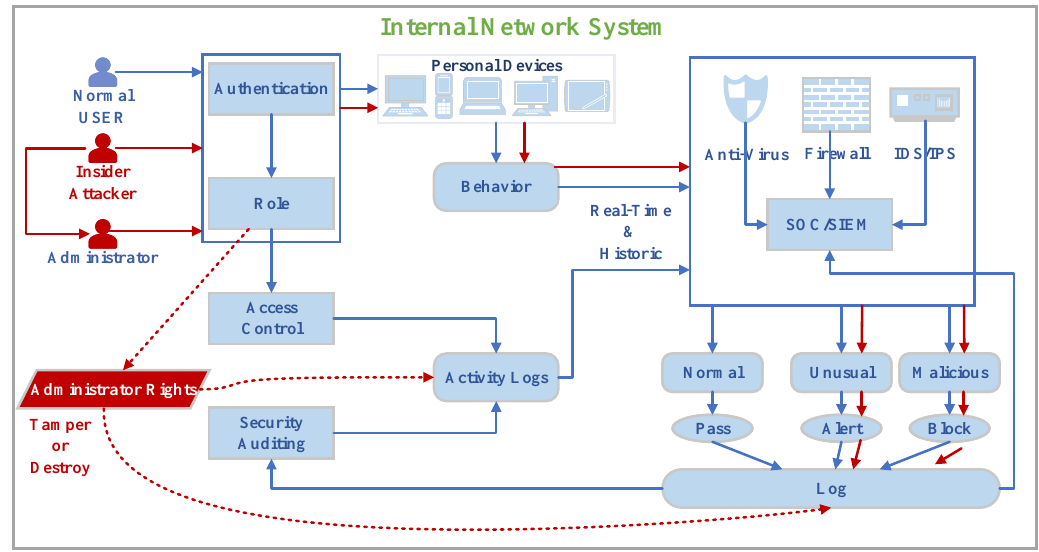
Figure 1. The insider threat model on the internal network